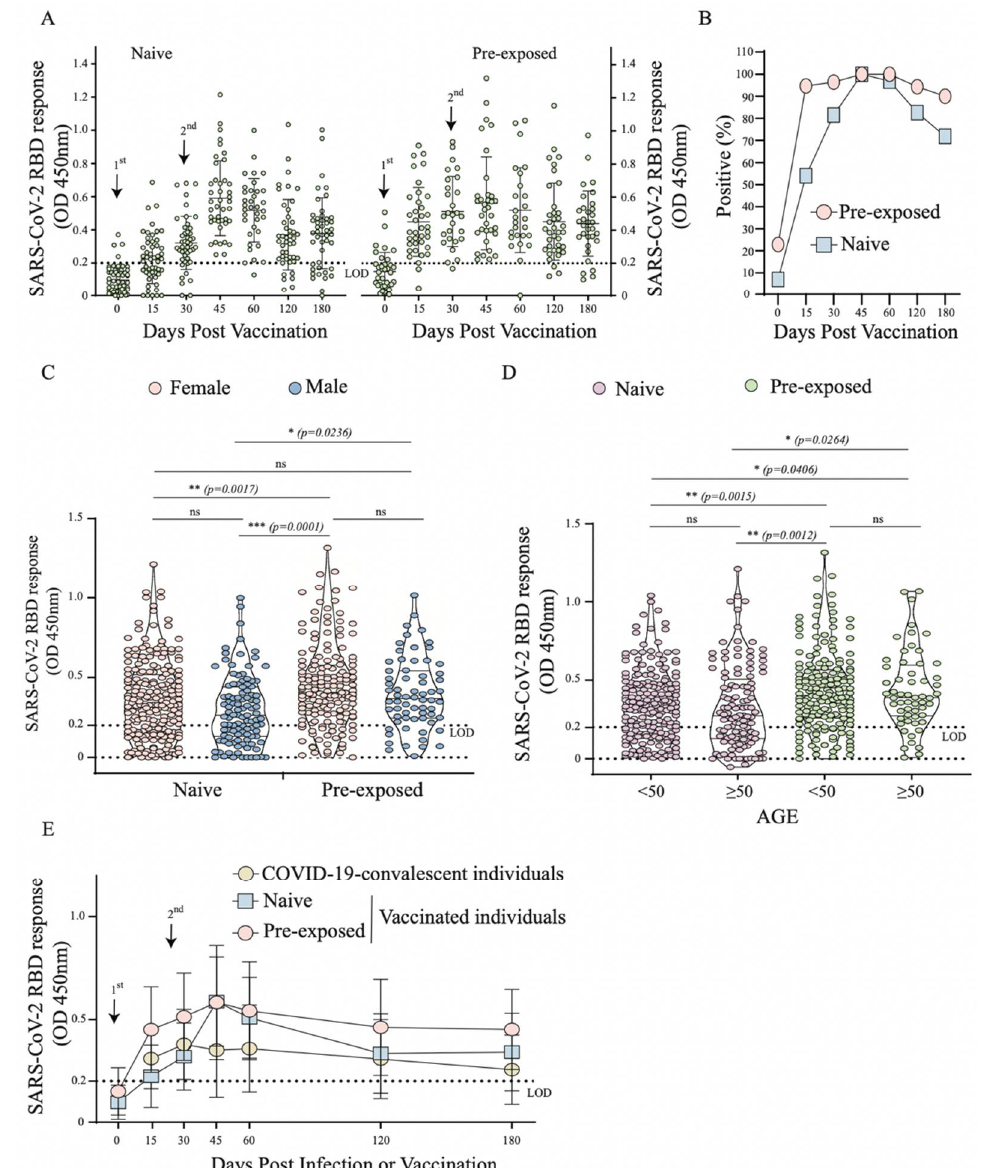
Figure 3. Profile of RBD specific antibody response in individuals after vaccination with CoronaVac vaccine through ELISA in Group 2 ( n = 96). ( A ) Distribution of OD values per day in Dotplot of the vaccinated naïve and SARS-CoV-2 pre-exposed individuals; ( B ) Percentage de seroconversion of the vaccinated naïve and SARS-CoV-2 pre-exposed individuals; ( C ) Comparative analysis of OD values in vaccinated naïve and SARS-CoV-2 pre-exposed individuals by gender (female and male). ( D ) Comparative analysis of OD values in vaccinated naïve and SARS-CoV-2 pre-exposed individuals by age group (<50 and ≥50), ( E ) Curve of RBD specific antibodies in COVID-19-convalescent (Group 1), vaccinated naïve and pre-exposed individuals. *— p < 0.05; **— p < 0.01; ***— p < 0.001; ns— p ≥ 0.05.